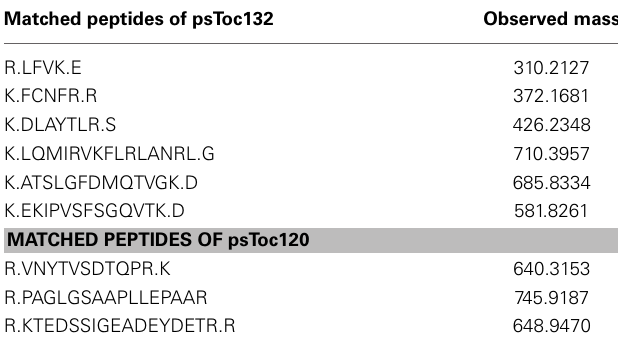
Table 1 | Identification of psToc132 and psToc120 by